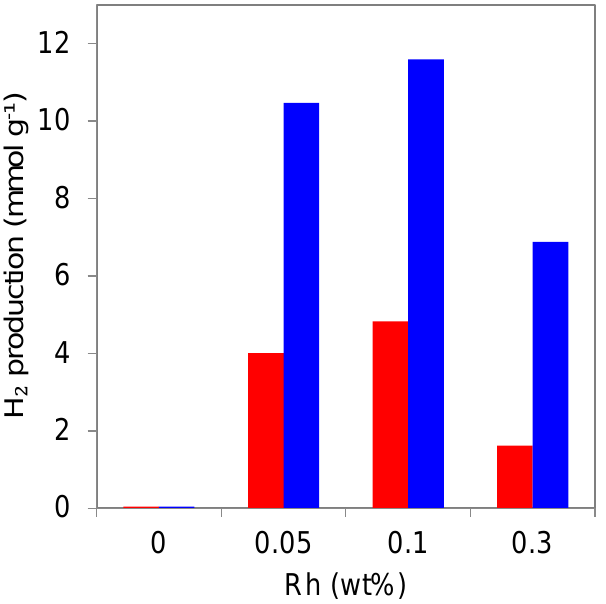
Figure 1. Effect of Rh 3+ ion concentration. TiO 2 , 50 mg; reaction time, 3 h; reaction temperature, 50 °C; formic acid concentration, 1 wt%.